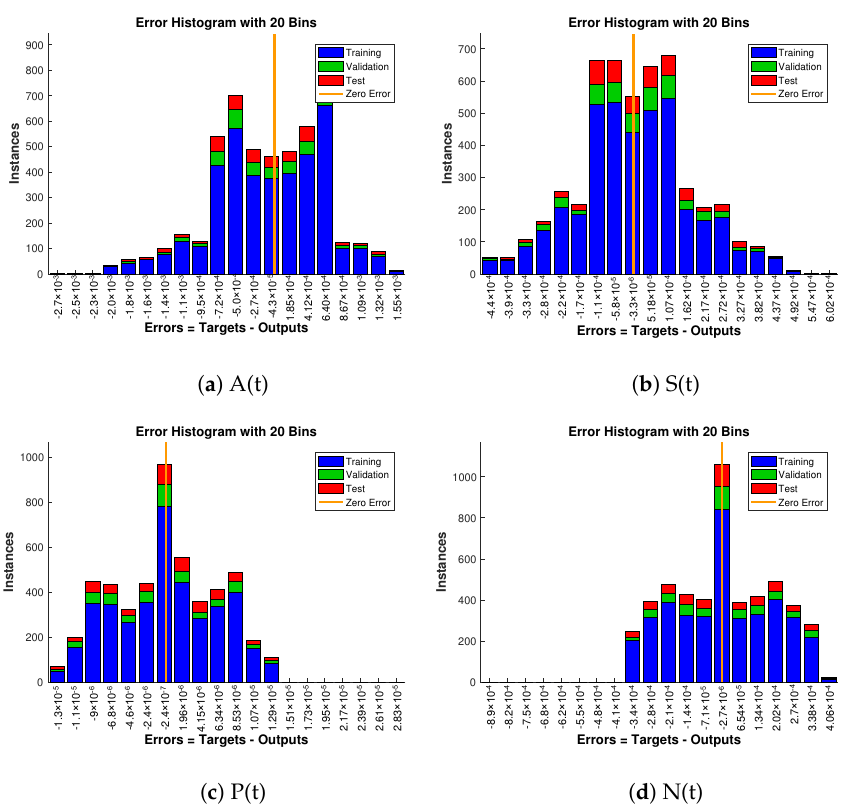
Figure 15. Error histogram analysis in relation to the target data and the approximate solutions for case 3.